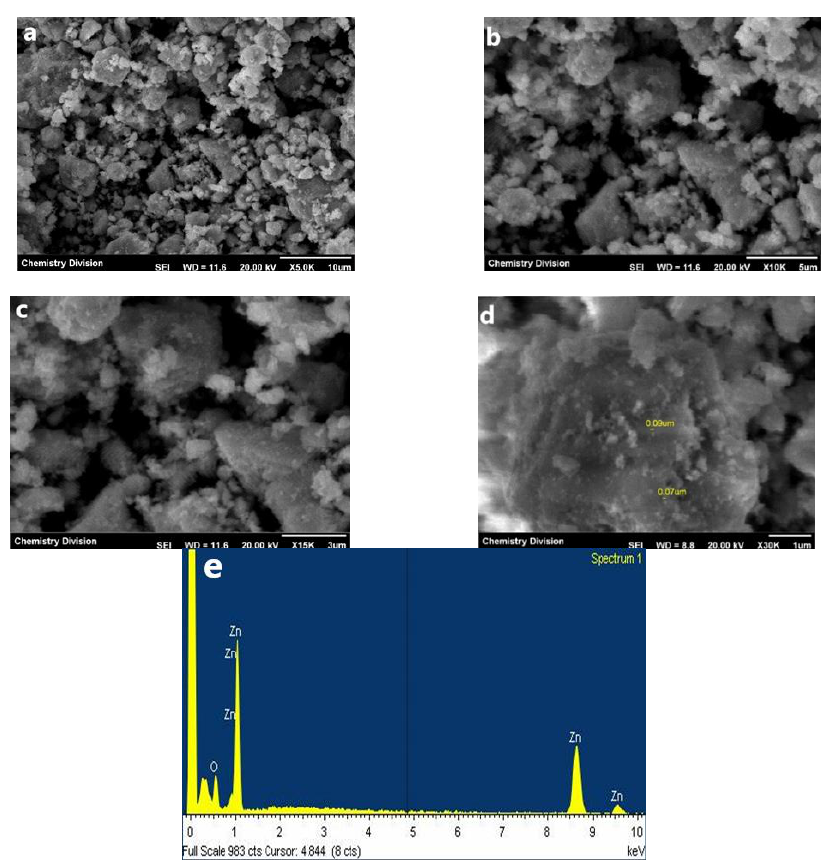
Figure 4. Field Emission Scanning electron microscopy (FESEM) images of ZnO NPs in magnification: ( a ) × 5.0 k; ( b ) × 10 k; ( c ) × 15 k; ( d ) × 30 k; ( e ) EDX (Energy Dispersive X-ray) Analysis of ZnO NPs. Table 1. Elemental Composition of ZnO.